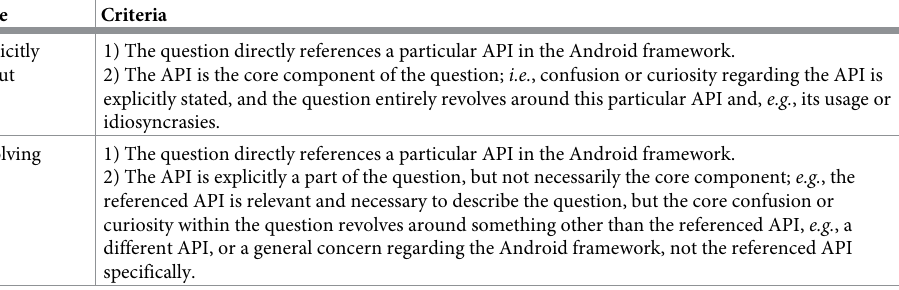
Table 2. Qualitative coding guide for questions about Android